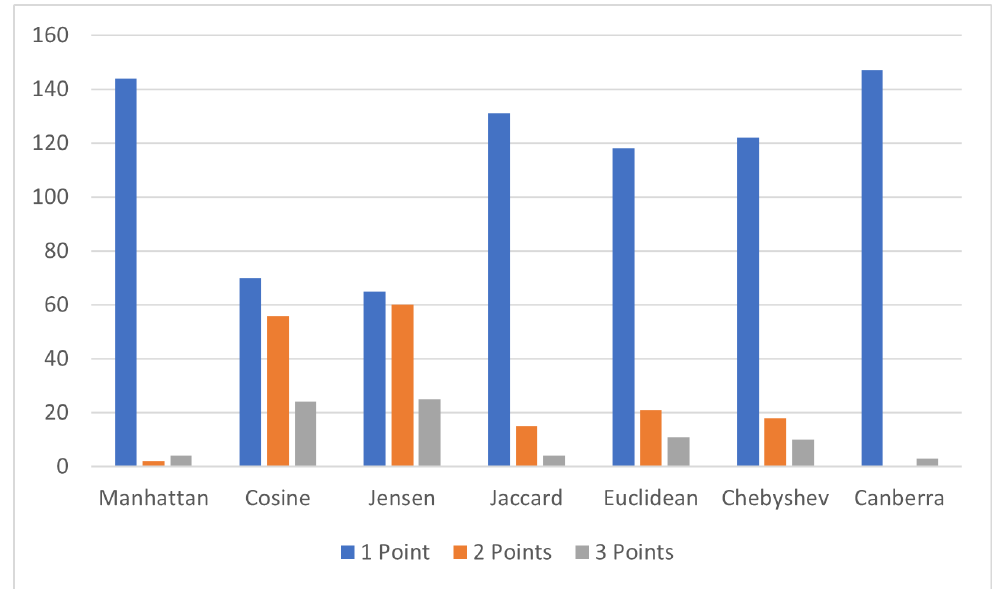
Figure 11. Human judgment results using NMF and respective similarity